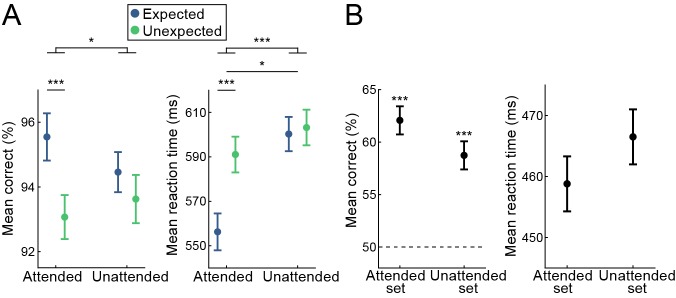
Behavioral results demonstrate statistical learning.(A) Behavioral benefits of expectations demonstrate statistical learning. Displayed are mean accuracy (left) and mean reaction time (right) + /- within subject SE. Responses to expected stimuli are significantly more accurate and faster, an effect exclusively observed during the objects attended condition. Thus, object identity expectations benefit behavioral performance during object classification and do not impact letter classification. (B) Pairs of both the objects attended image set and the objects unattended image set were classified significantly above chance, indicating a learning of the pairs for both conditions. Displayed are mean accuracy (left) and mean reaction time (right) during the post-scanning pair recognition task, + /- within subject SE. The dashed line indicates chance level. During the pair recognition task, no differences in either classification accuracy (left) or response speed (right) were observed between pairs previously belonging to the objects attended task compared to the objects unattended task. *p<0.05. ***p<0.001.10.7554/eLife.47869.014Figure 5—source data 1.Behavioral results demonstrate statistical learning.The source data file contains separate JASP files containing the behavioral performance data and conducted analyses for the object and letter classification tasks (both in terms of RTs and response accuracy; Figure 4A), as well as data from the post-scanning object recognition task (Figure 4B).